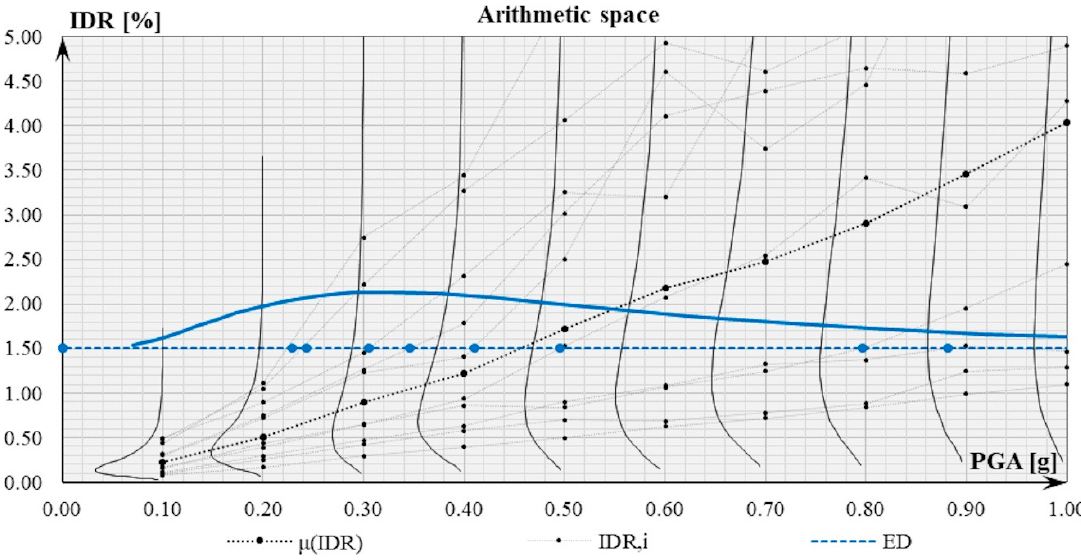
Figure 16. IDR,i values in arithmetic space and their corresponding PDFs and ED PDF.